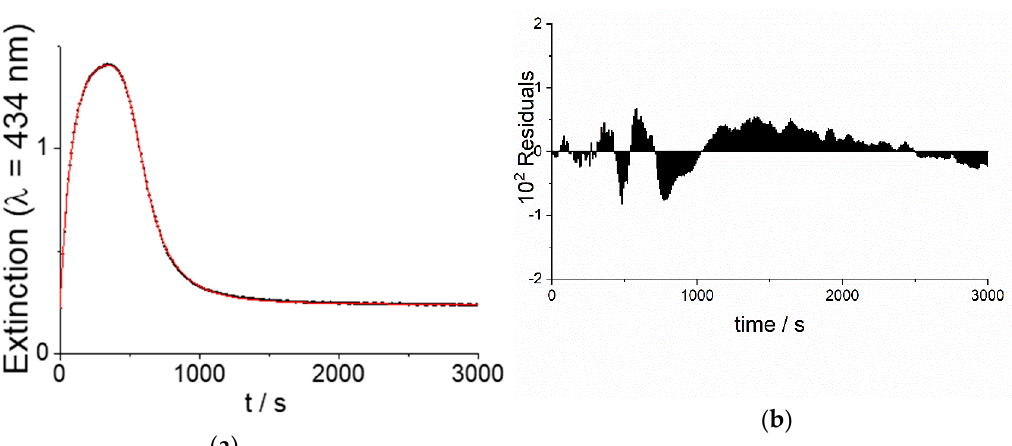
Figure 4. ( a ) Extinction time trace for the demetallation of ZnTPPS 4 (3 μ M) and the consecutive formation of H 2 TPPS 4 J-aggregates at constant ionic strength (IS = 0.6 M, ZnSO 4 ) and [H 2 SO 4 ] = 0.05 M. The solid line represents the best-fitted curve to the experimental data according to Equation (3). Residuals, accounting for the validity of the model, are shown on the bottom. ( b )